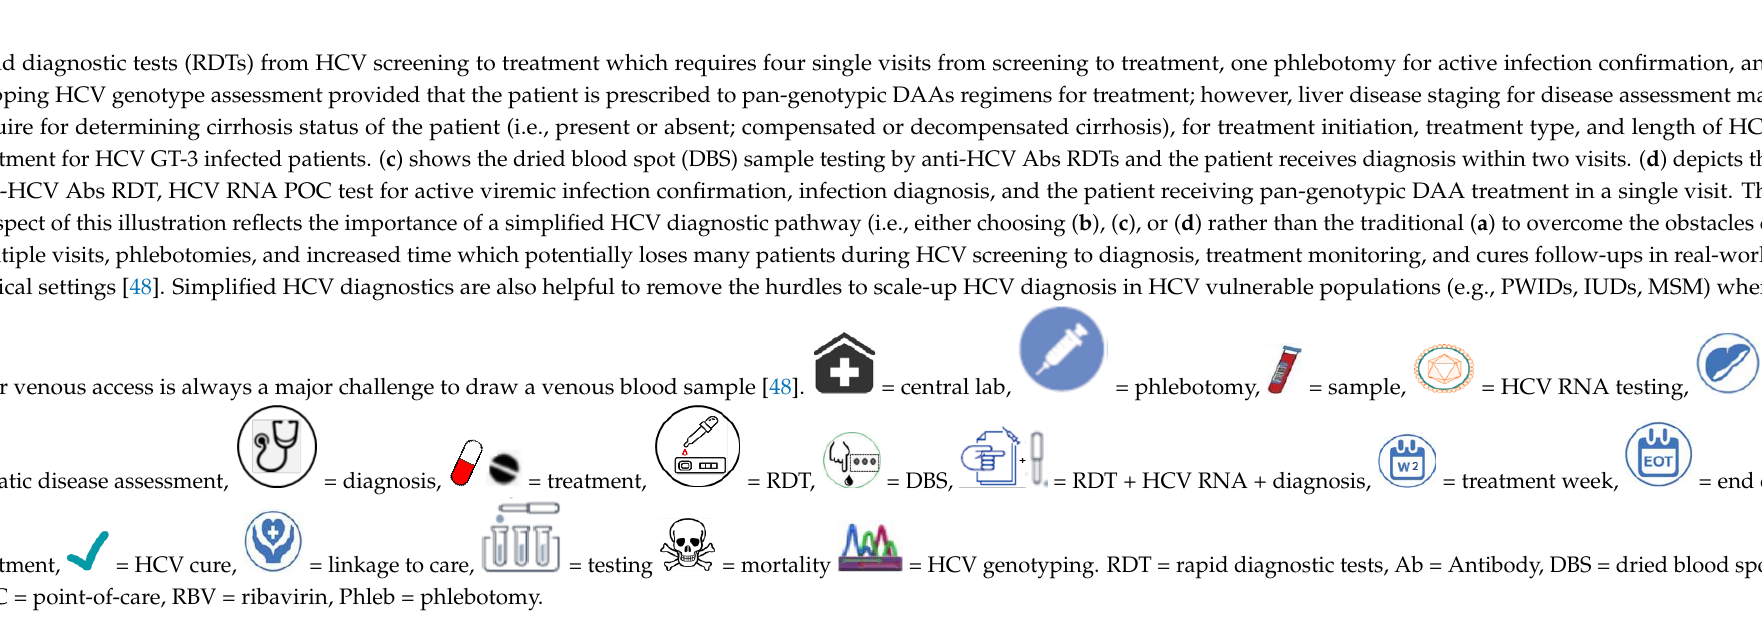
9 of 71 Figure 1. HCV care cascade strategies and WHO goals of HCV elimination by 2030. ( 1a ) represents HCV cure pathway strategies, policies, and procedures at diagnostic (depicted in Figure 1a as ‘ a ’), linkage to care (depicted in fig 1a as ‘ b ’), and treatment uptake levels (depicted in fig 1a as ‘ c ’). The diagnostic approaches, treatment choices, and measures to be taken, which one seems feasible to make rapid progress toward elimination goals for hepatitis C by 2030, and what should be the key focus are mentioned under each category. ( 1b ) represents the comparison of HCV diagnosis, treatment uptake, and mortality before the DAAs era, HCV elimination goals achieved until 2020, and the targets for the next 10 years